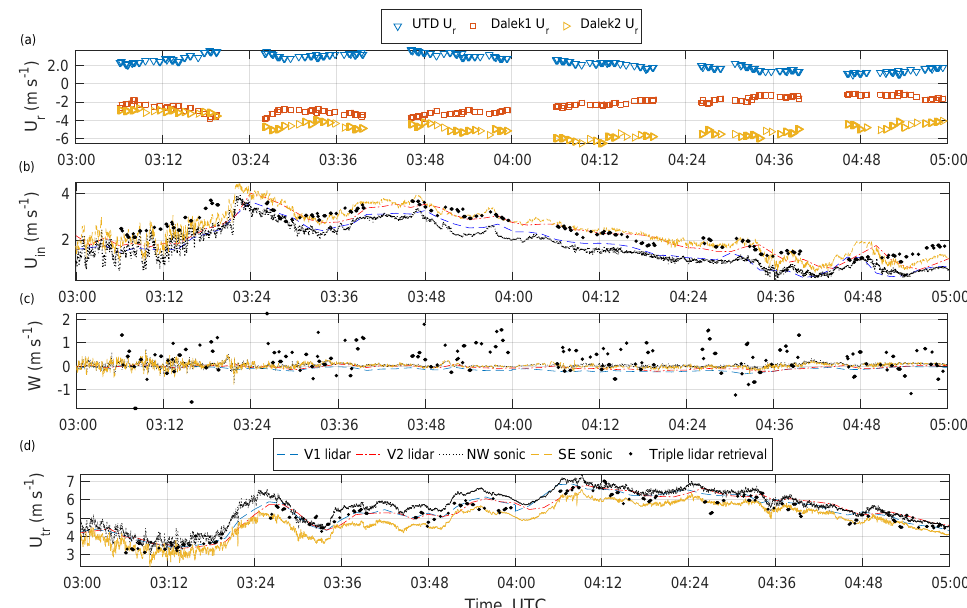
Figure 5. 3-D velocity retrieved for virtual tower 1 at 100m height. Assessment of the triple RHI scans with sonic anemometer, and lidar profiler data: (a) radial velocities; (b) in-plane horizontal velocity, U in ; (c) vertical velocity, W ; (d) transverse horizontal velocity, U tr .